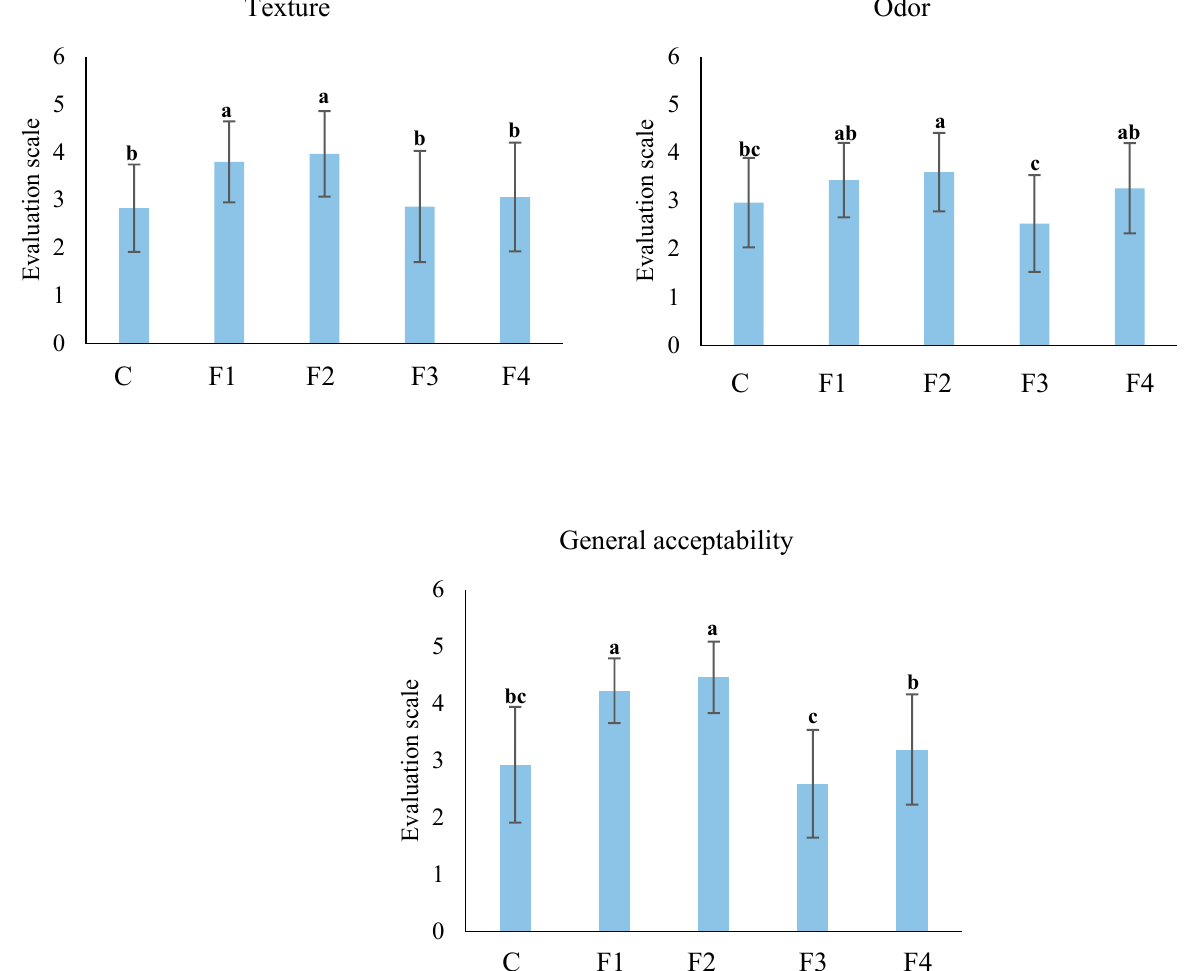
Figure 4. Effect of different edible coatings on sensory evaluations of Ciklamen and Modoc after six months of cold storage at 4 ± 2 °C and 90 ± 5% RH. Data are expressed as mean ± SD, n = 40. The different letters are letters on the bars are indicative of statistical significance ( p < 0.05). C: control. F1: sodium alginate. F2: potato starch + sodium alginate emulsion with oregano oil. F3: zein + chitosan emulsion with oregano oil. F4: potato starch + chitosan + sodium alginate emulsion with oregano oil.